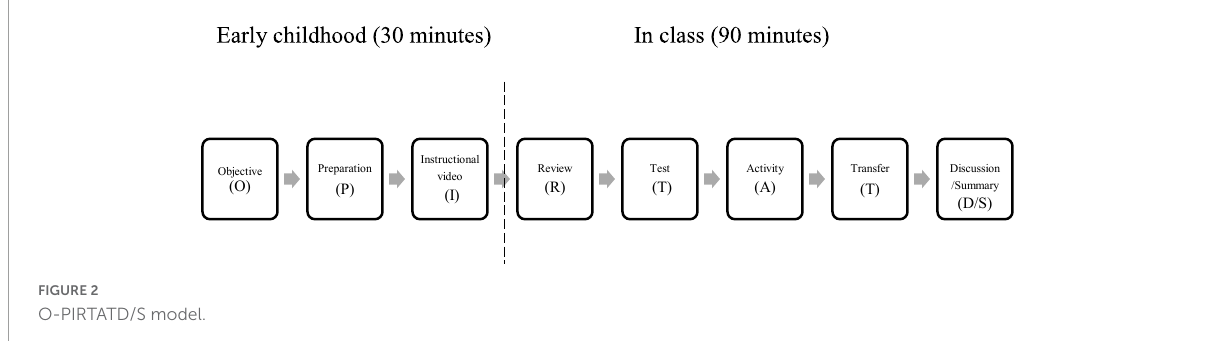
FIGURE2 O-PIRTATD/S